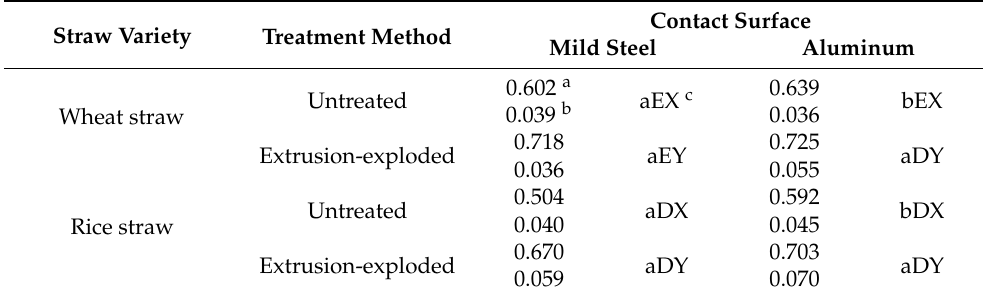
Table 7. Comparison of the coefficients of sliding friction between untreated and extrusion-exploded straw, wheat straw and rice straw, and mild steel and aluminum surfaces. Straw Variety